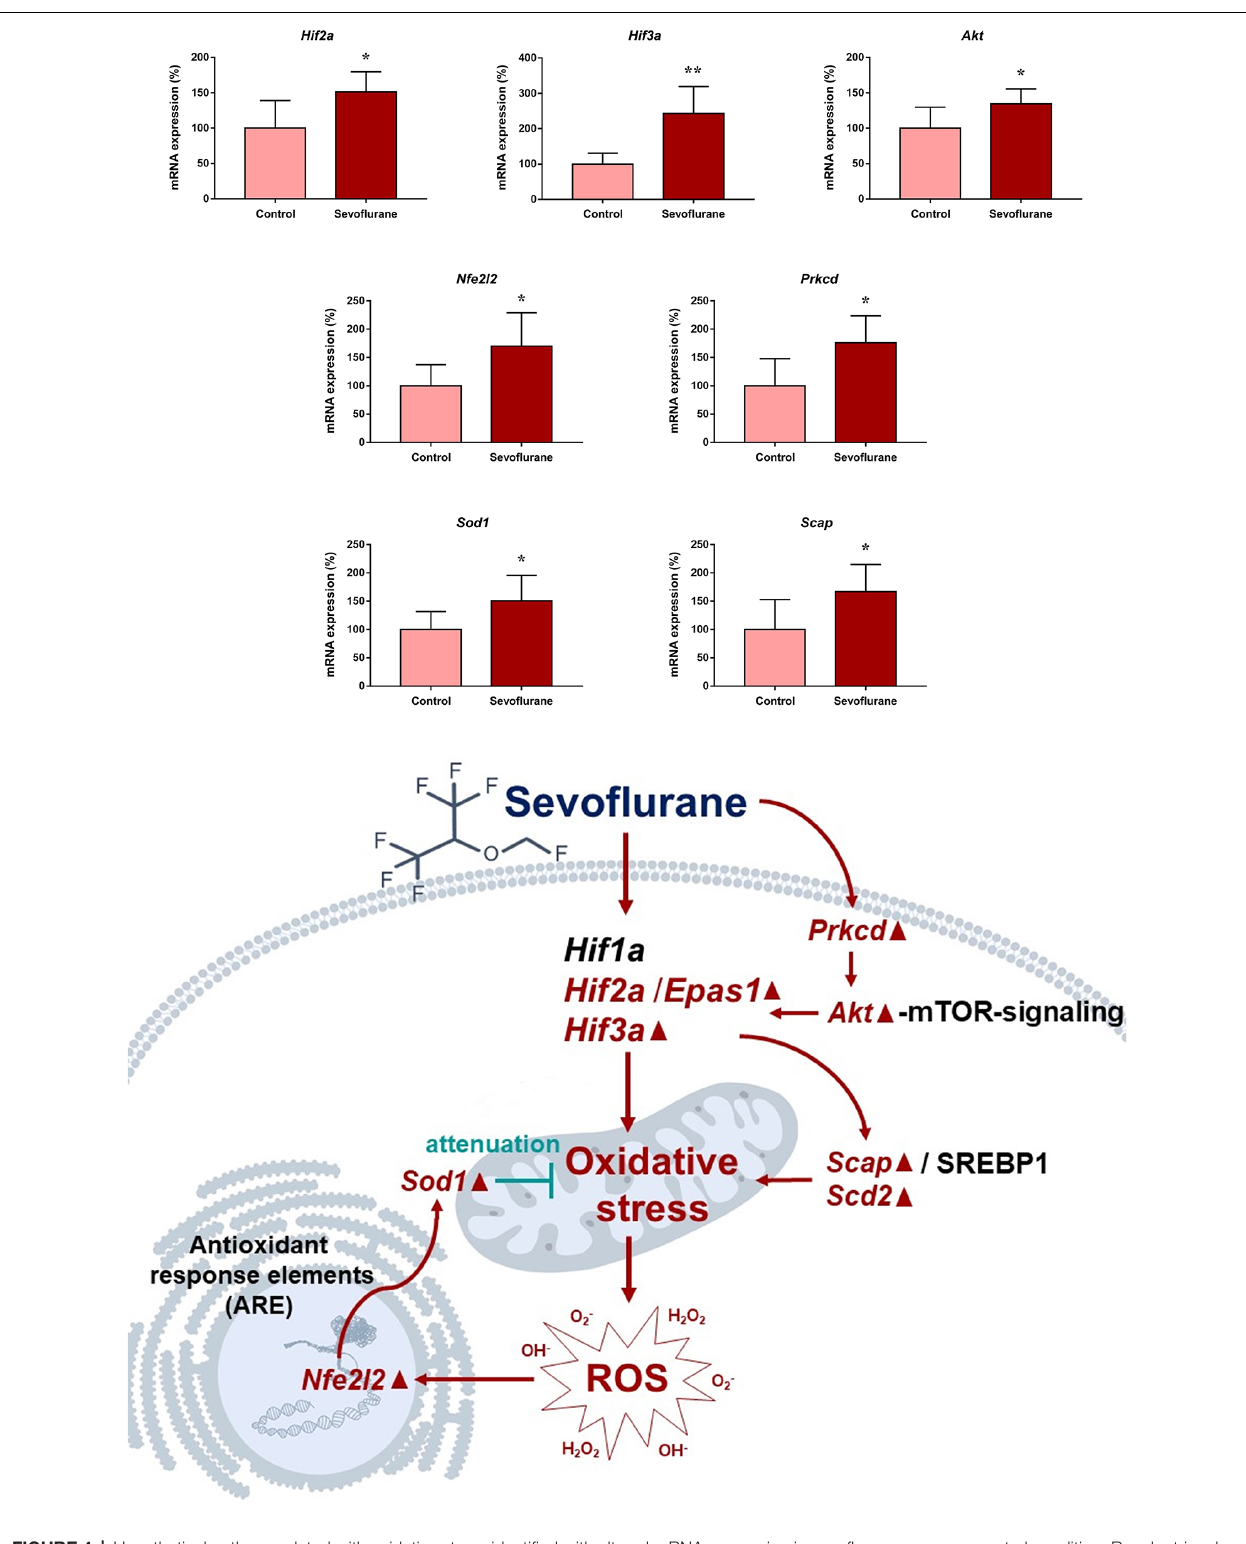
FIGURE 4 | Hypothetical pathway related with oxidative stress identified with altered mRNA expression in sevoflurane group vs. control condition, Regular triangle represents genes up-regulated; inverted triangle represents genes down-regulated; Graphs show the difference in expression of Hif2a , Hif3a , Akt , Nfe2l2 , Prkcd , Sod1 and Scap for sevoflurane anesthesia group and controls (* p < 0.05; ** p < 0.01).